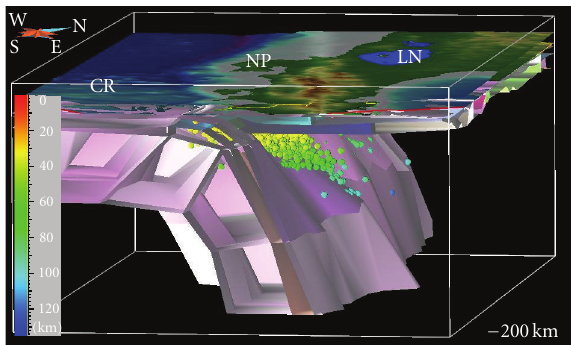
Figure 13: The 3D density model is compiled by the IGMAS software [6, 7]. It is constrained by the seismological information displayed in Figures 11 and 12. The model is seen from the southeast together with the hypocenters and the DEM as surface. The model dips down reaching a depth of 200 km. It was mainly compiled by V. Giszas.